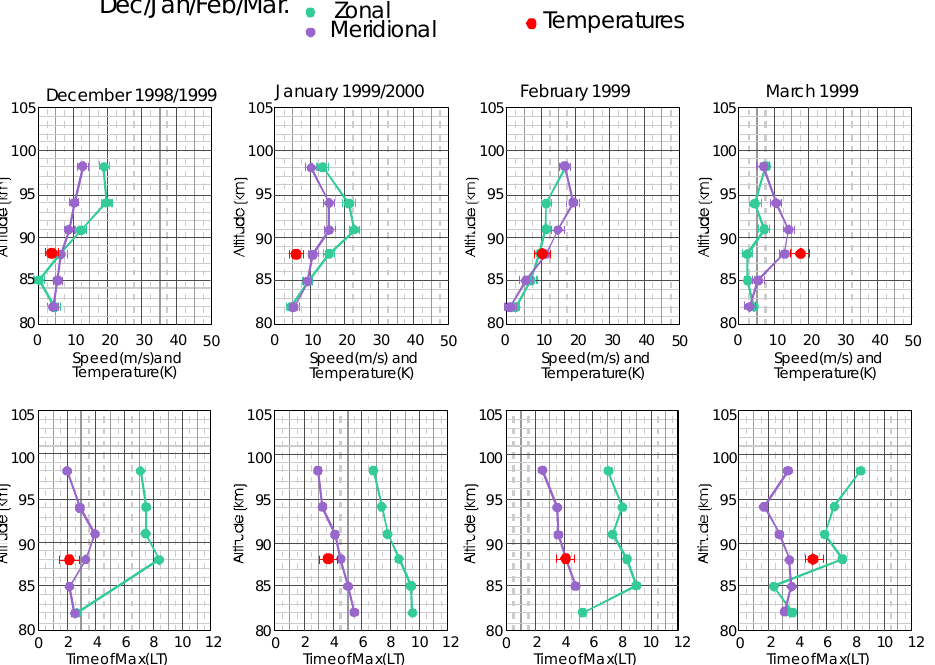
Fig. 3 Fig. 3. As for Fig. 2, but for semidiurnal components at